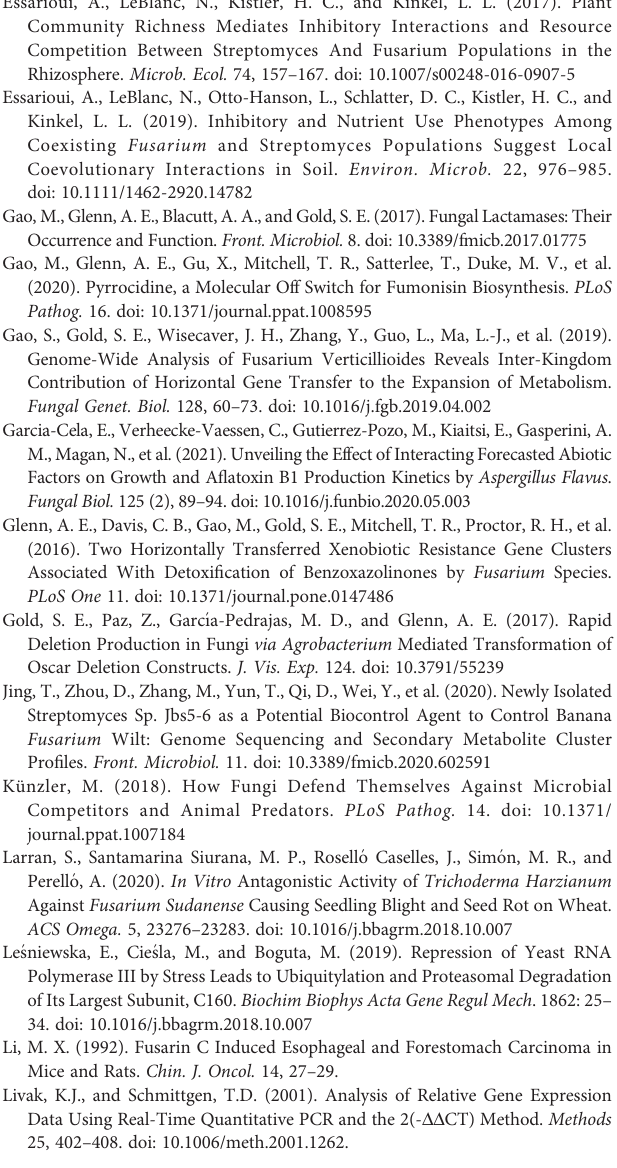
Supplementary Table 5 | Comparison of expression of selected genes in RNA- Seq and RT-qPCR. Supplementary Figure 1 | Fusarium verticillioides-Streptomyces dual-culture experimental design. (A) Growth of Streptomyces and F. verticillioides cultures after 48 h of solo growth. (B) F. verticillioides grown fi lter, after 2 days of growth, placed (without direct contact) within the ring of Streptomyces strain growth. (C) Mycelial sample collection. Supplementary Figure 2 | RT-qPCR veri fi cation of select DEGs. To verify observed RNA-Seq differential expression, RT-qPCR was performed on select genes. (A) , (B) , and (C) , correspond to genes from the s2832 2 h, s2831 8 h, and s2831 24 h samples, respectively. Note that scales vary greatly, adjusted to show expression of each gene normalizing the control treatment as a value of 1. Supplementary Figure 3 | Design and con fi rmation of gene deletion of induced beta-lactamase FVEG_13172. (A) Deletion strategy for FVEG_13172 with color